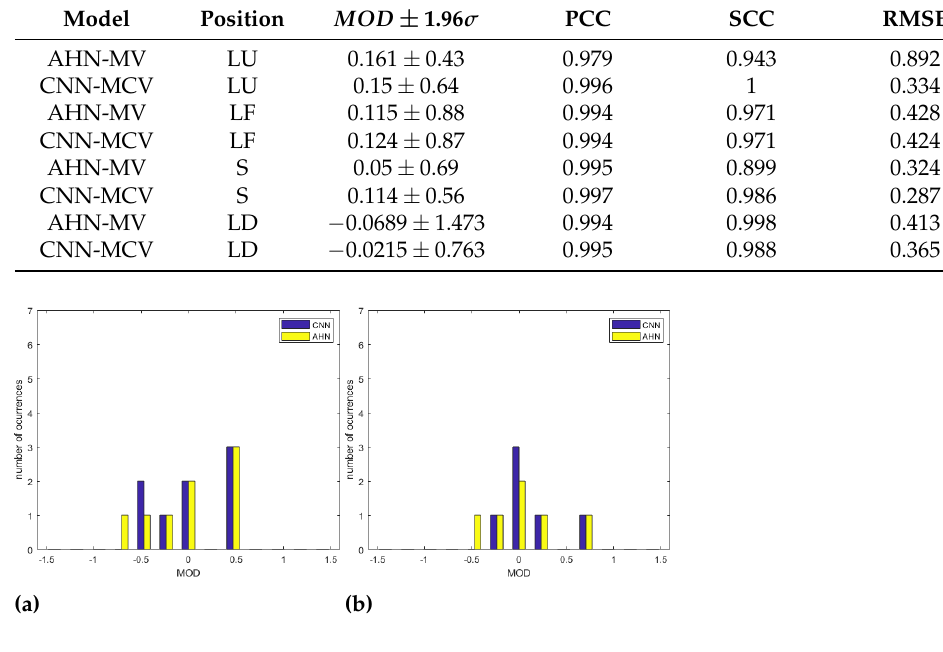
Table 10. Bland–Altman metrics, correlation metrics (SCC and PCC) and RMSE for CNN and AHN strategies according to the position of the subject.